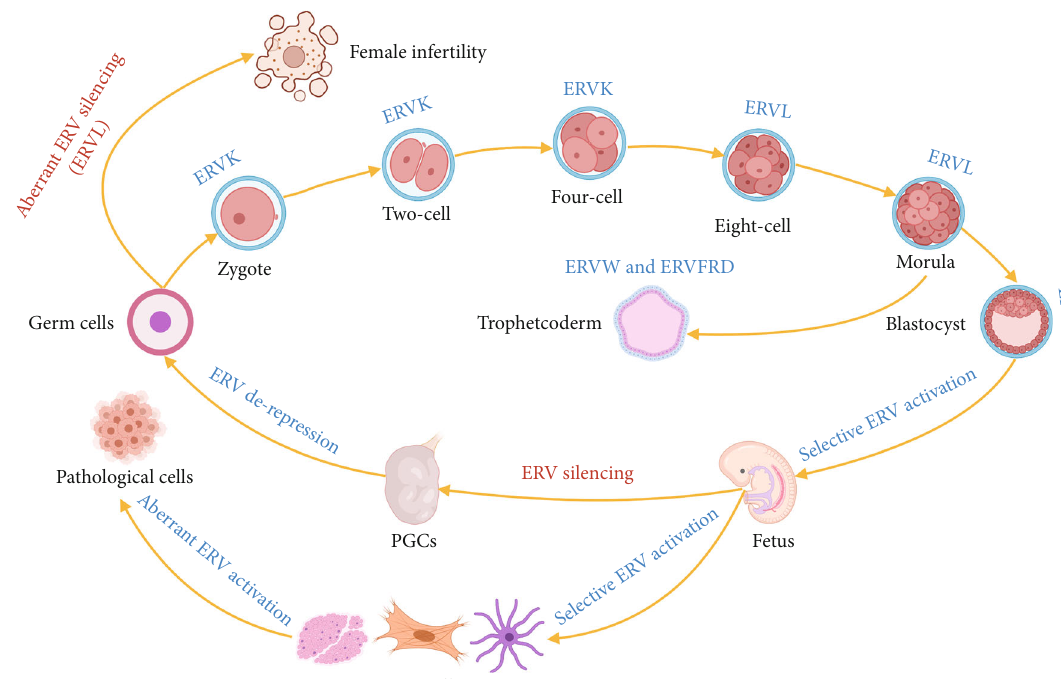
Figure 1: The dynamic regulation ERVs during development. During embryonic and somatic development, ERVs are selectively activated, whereas aberrant activation or silencing of ERVs results in pathological